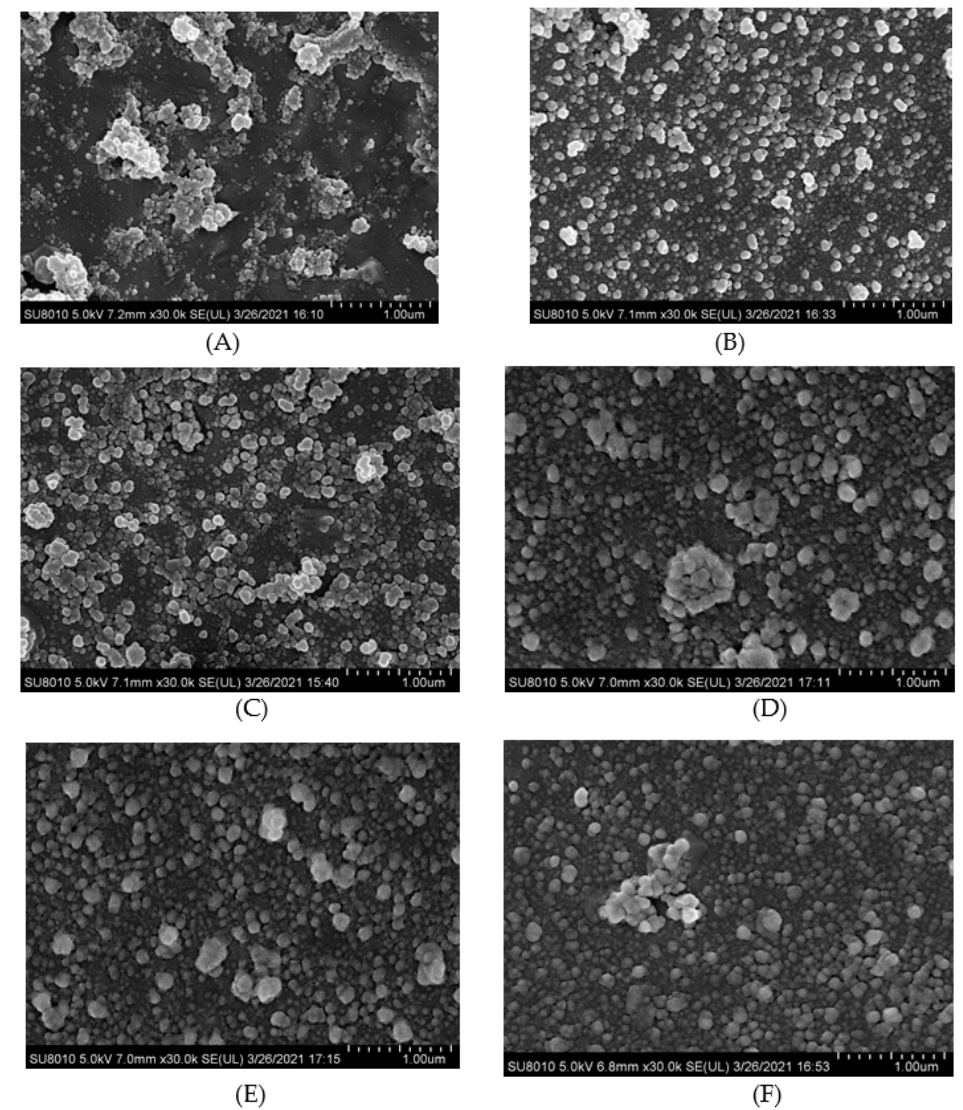
Figure 6. Cryo-scanning electron microscope images of HPI and covalent HPI-EGCG complexes at EGCG concentrations of 1, 2, 3, 4, and 5 mM. ( A ) HPI, ( B ) HPI-1 Mm EGCG, ( C ) HPI-2 mM EGCG, ( D ) HPI-3 mM EGCG, ( E ) HPI-4 mM EGCG, and ( F ) HPI-5 mM EGCG.